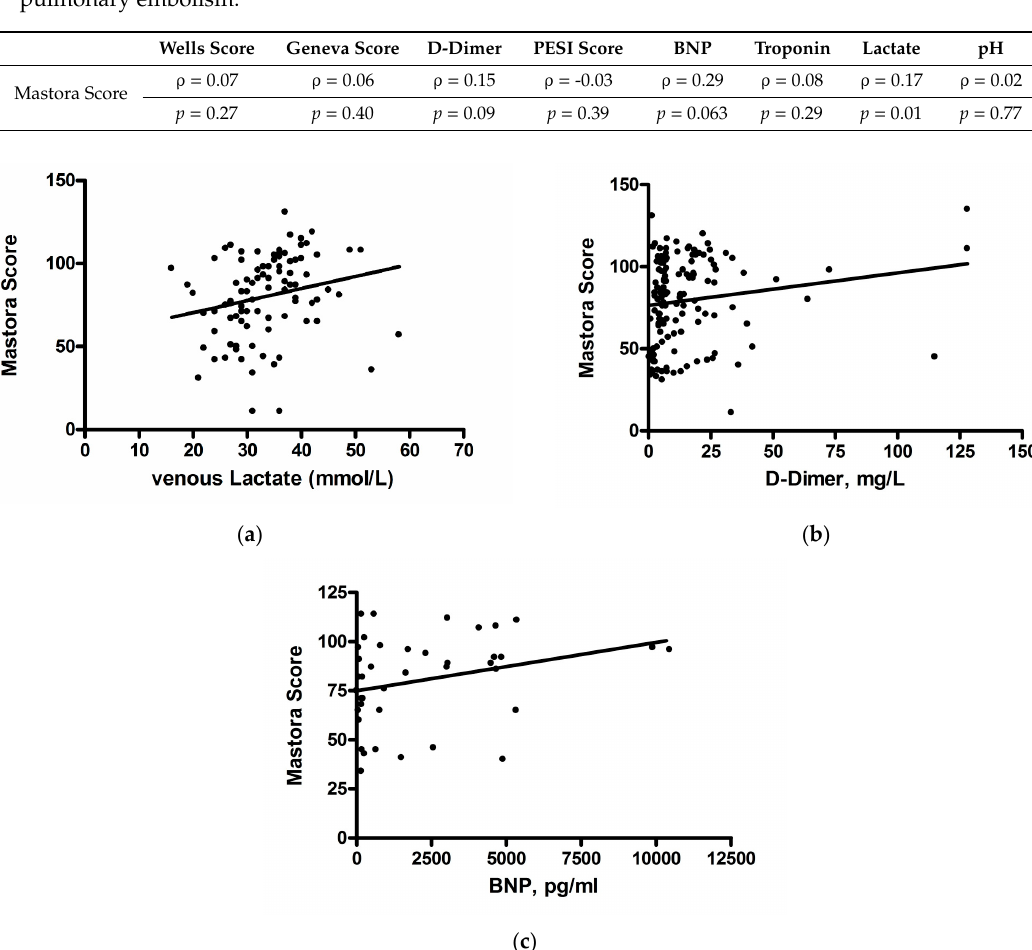
Table 2. Correlations between Mastora score and clinical/serological parameters in patients with pulmonary embolism.